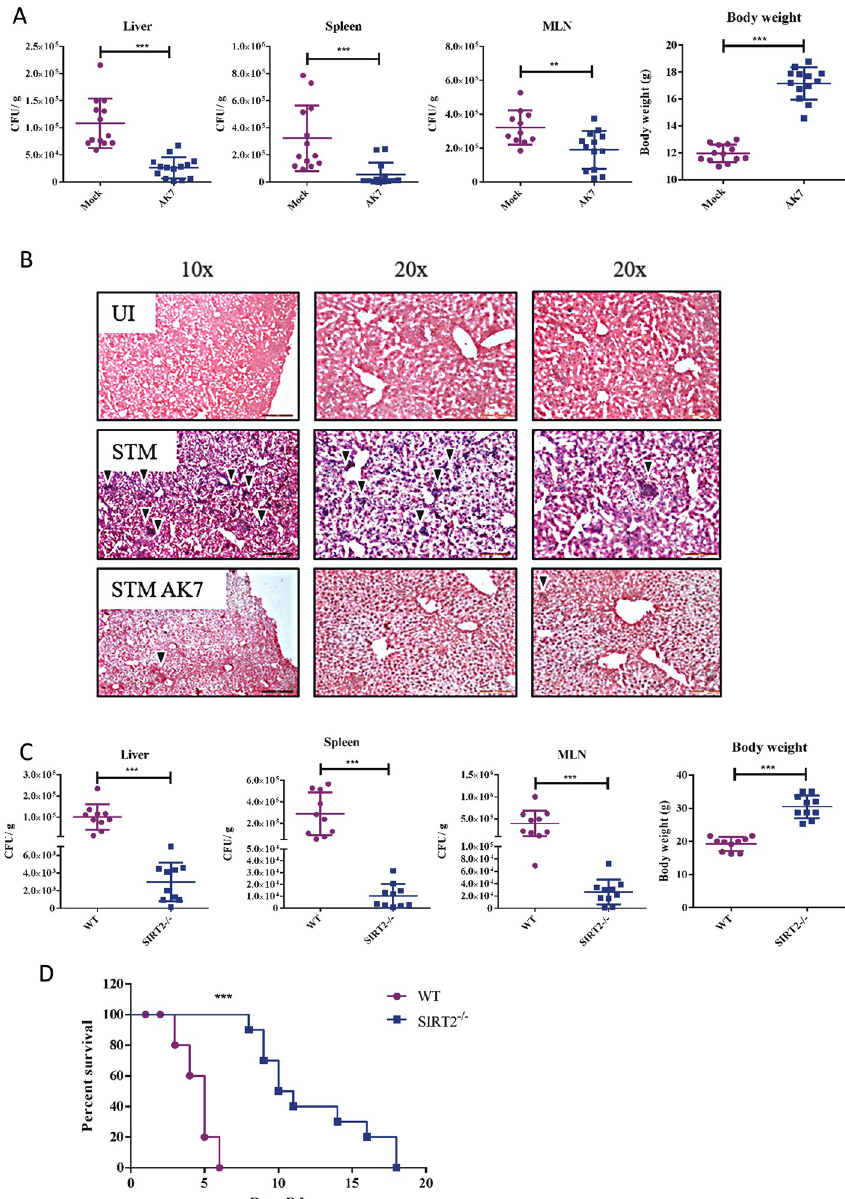
Fig 7. SIRT2 inhibition is protective during Salmonella pathogenesis in-vivo . A. Organ burden in spleen, liver, MLN and infected mice body weight in presence and absence of SIRT2 inhibitor 5 days post infection. (Mock-only vehicle treated, AK7- 15 mg/kg body weight AK7 was intraperitoneally injected everyday) (Data are presented from 3 independent experiments). B. Representative image of hematoxylin and eosin staining of the liver section to assess Salmonella infection mediated liver damage 5 days post infection. (UI- uninfected, STM- Salmonella infected, STM AK7- Salmonella infected and AK7 treated) C. Organ burden in spleen, liver, MLN and infected mice body weight in wild type and SIRT2 -/- mice 5 days post infection. Data are presented from 3 independent experiments. (unpaired two- tailed Student’s t- test, p- value, ��� < 0.0001, �� < 0.001, � < 0.01) D. Percentage survival in response to lethal dose of Salmonella infection (Log-rank (Mantel-Cox) Test, p- value, ��� < 0.0001, �� < 0.001, � < 0.01).